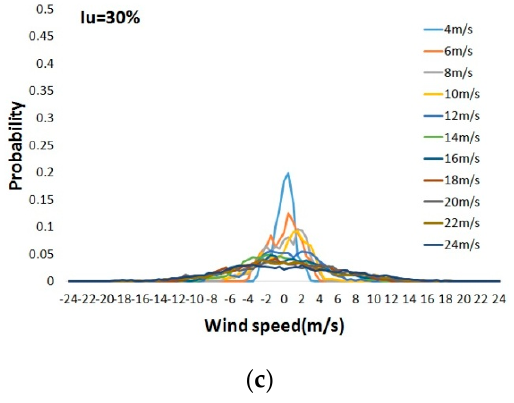
Figure 5. Normalized wind speed distribution with different turbulence scales: ( a ) 10%; ( b ) 20%; ( c ) 30%.